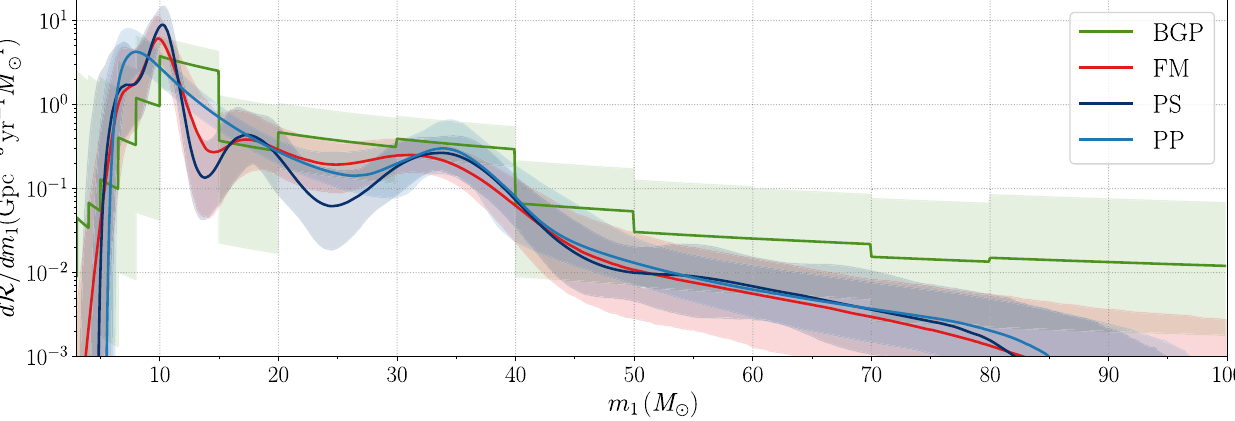
FIG. 11. The differential merger rate for the primary mass predicted using three nonparametric models compared to the fiducial PP model. Solid curves are the medians and the colored bands are the 90% credible intervals. These models offer increased flexibility compared to phenomenological models in predicting the population. The PS applies a perturbation to the primary mass in a modified version of our fiducial PP model that does not include the Gaussian peak. FM models the chirp mass, mass ratio, and aligned-spin distribution as a weighted sum of mixture components. Both of these models incorporate a single-parameter redshift evolution of the merger rate described in Eq. (7). The BGP models the two-dimensional mass distribution as a binned Gaussian process which is piecewise constant in log m , illustrating the same analysis as presented in Sec. IV with FAR < 0 . 25 yr − 1 . All three models infer a local i maxima in the merger rate at around 10 amd 35 M ⊙ . In addition, FM and PS models are consistent with a feature around 17 M ⊙ , but with a limited